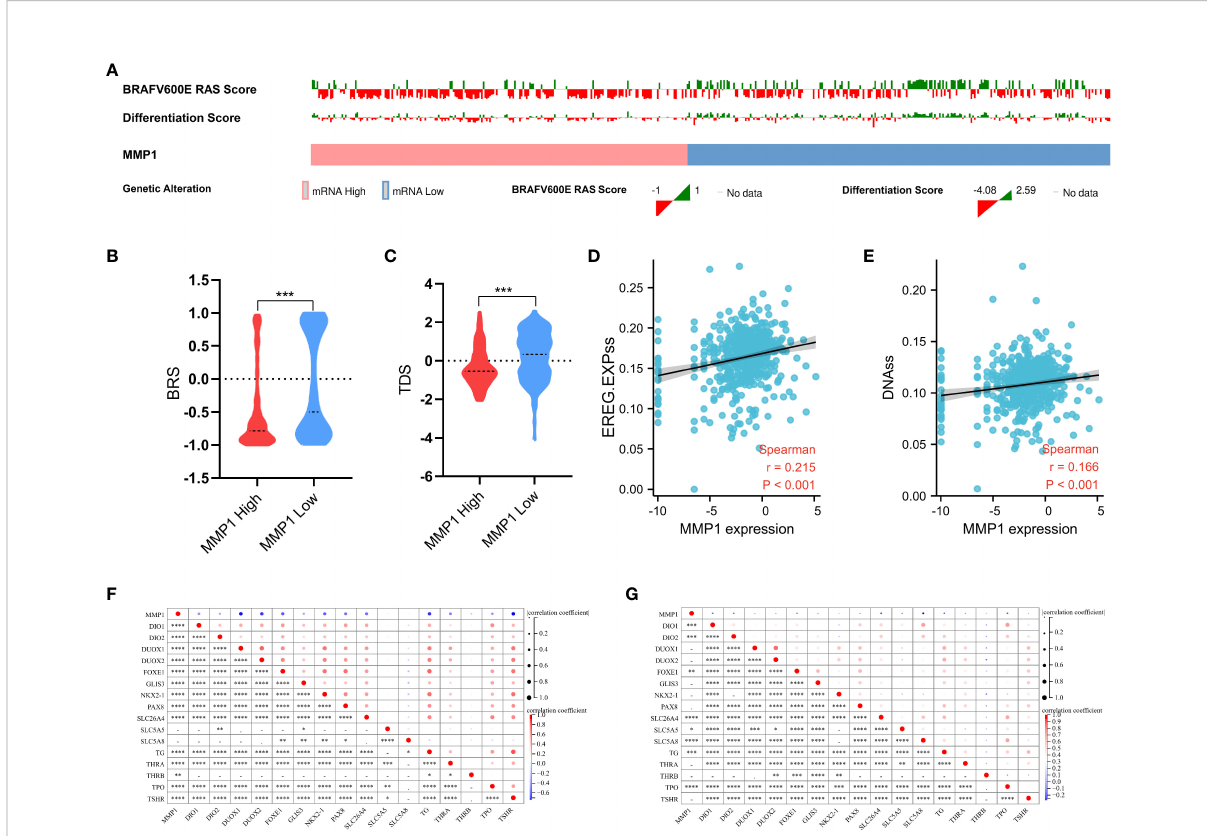
FIGURE 6 Analysis of the mutation, stemness, and differentiation. (A) Landscape of BRAF V600E - RAS score and thyroid differentiation score based on MMP1 levels in PTC samples from TCGA. MMP1 high group had higher BRS (B) and lower TDS (C) . MMP1 was signi fi cantly positively correlated with the PTC stemness via both EREG.EXPss method (D) and DNAss method (E) . MMP1 was signi fi cantly negatively correlated with most TDS genes in both the GEO cohort of PDTC/ATC and PTC (F) and TCGA cohort of PTC (G) . GEO, the Gene Expression Omnibus; PDTC, poorly differentiated thyroid cancer; ATC, anaplastic thyroid cancer; PTC, papillary thyroid cancer; TCGA, The Cancer Genome Atlas; BRS, BRAF V600E - RAS score; TDS, thyroid differentiation score. *P <0.05, **P <0.01, ***p <0.001, and ****p